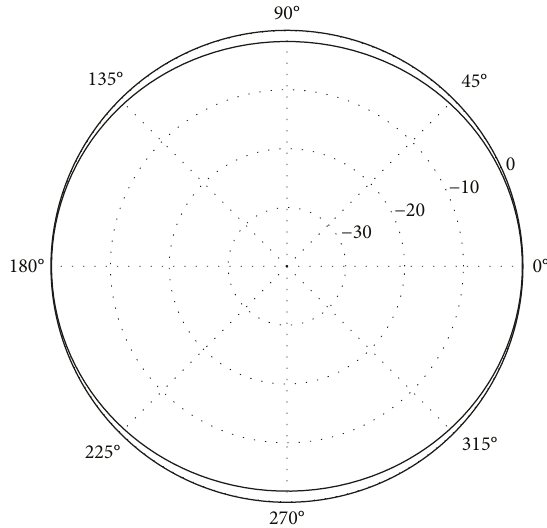
Figure 8: Radiation pattern on E-plane